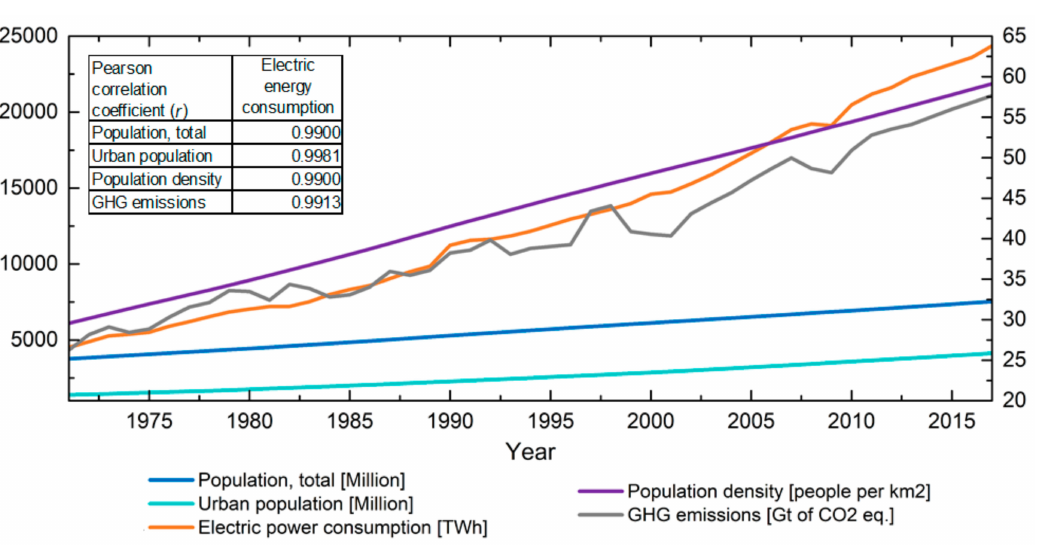
Figure 1. Correlation between urban population and electric energy consumption. Source: Created by authors using data from